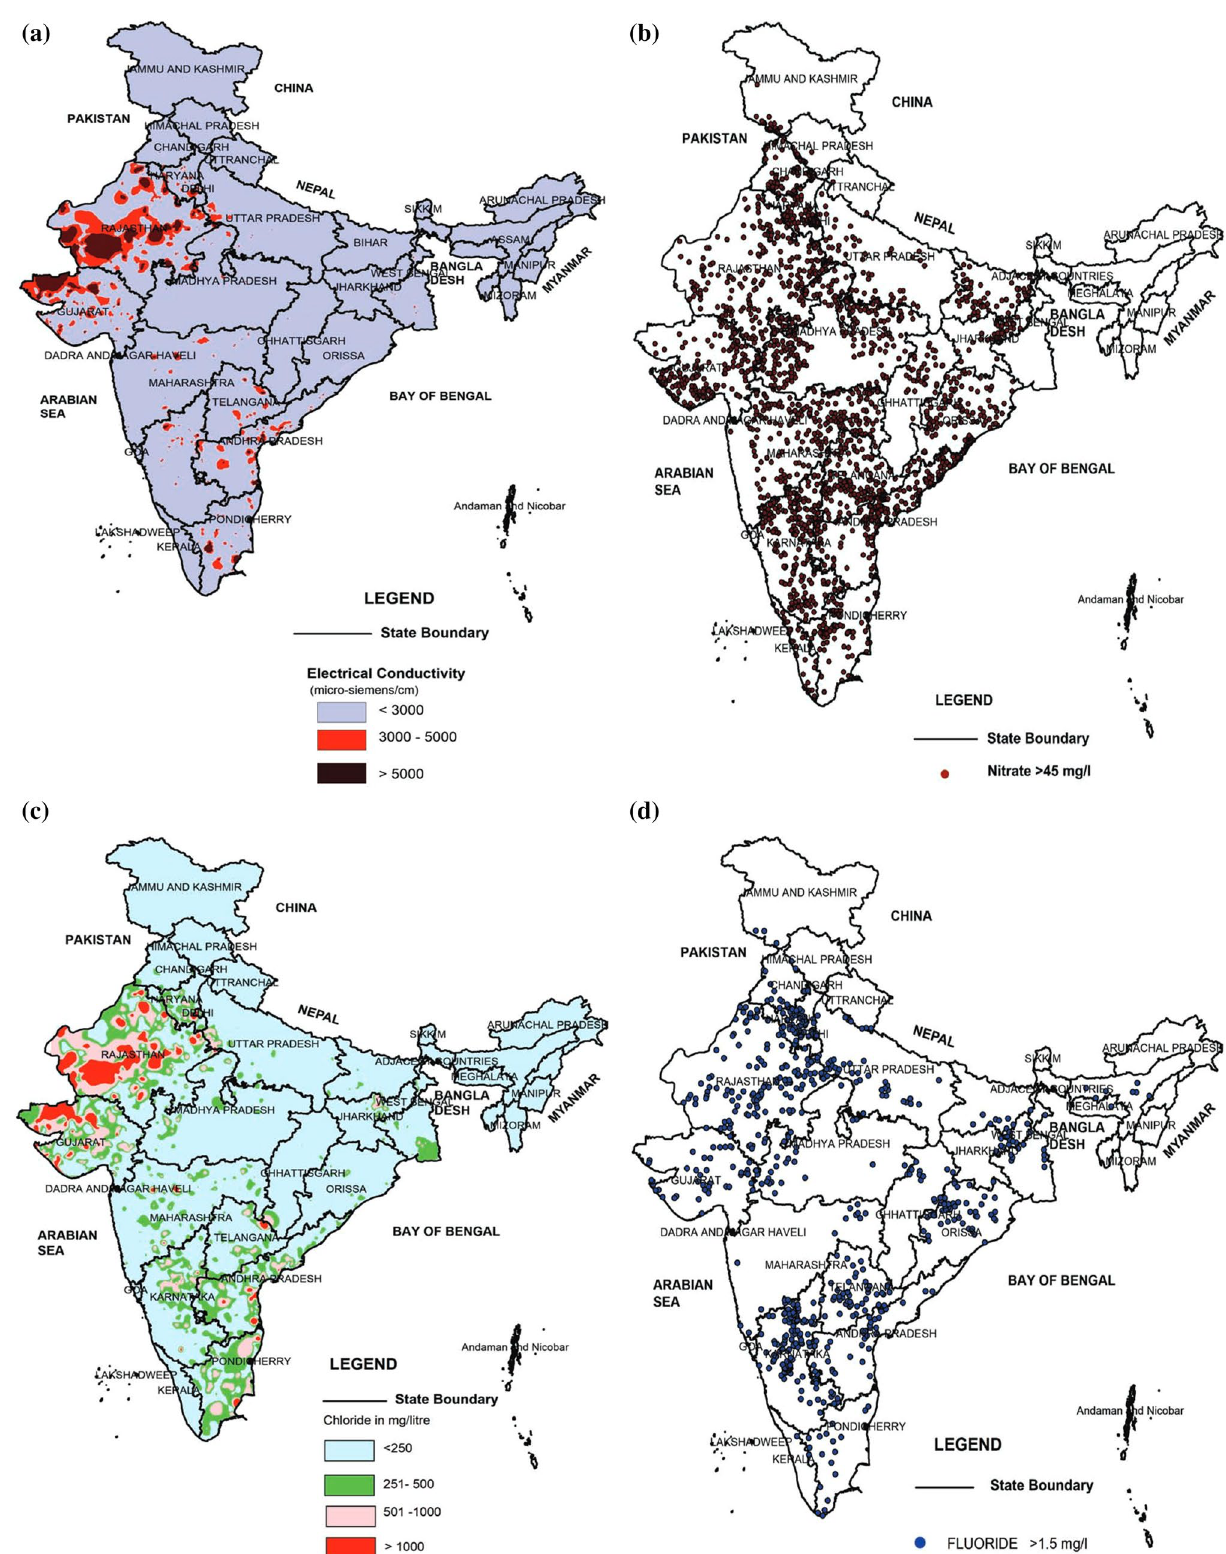
Fig. 5 The water quality condition of India in terms of physicochemical parameters, a Electrical conductivity, b Nitrate, c Chloride, and d Fluo- ride ( Source CGWB